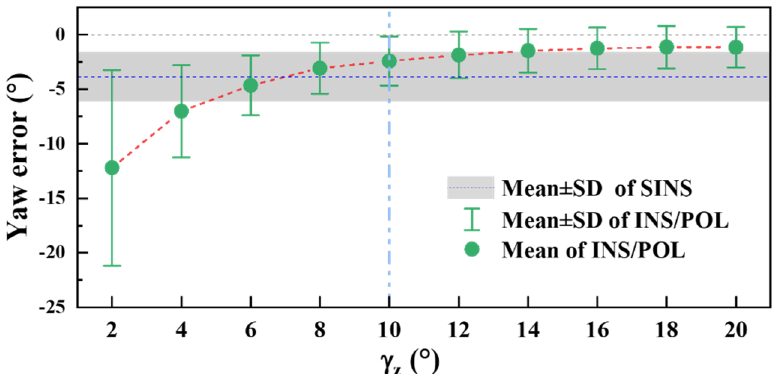
γ in the range from 2° to 20°. The